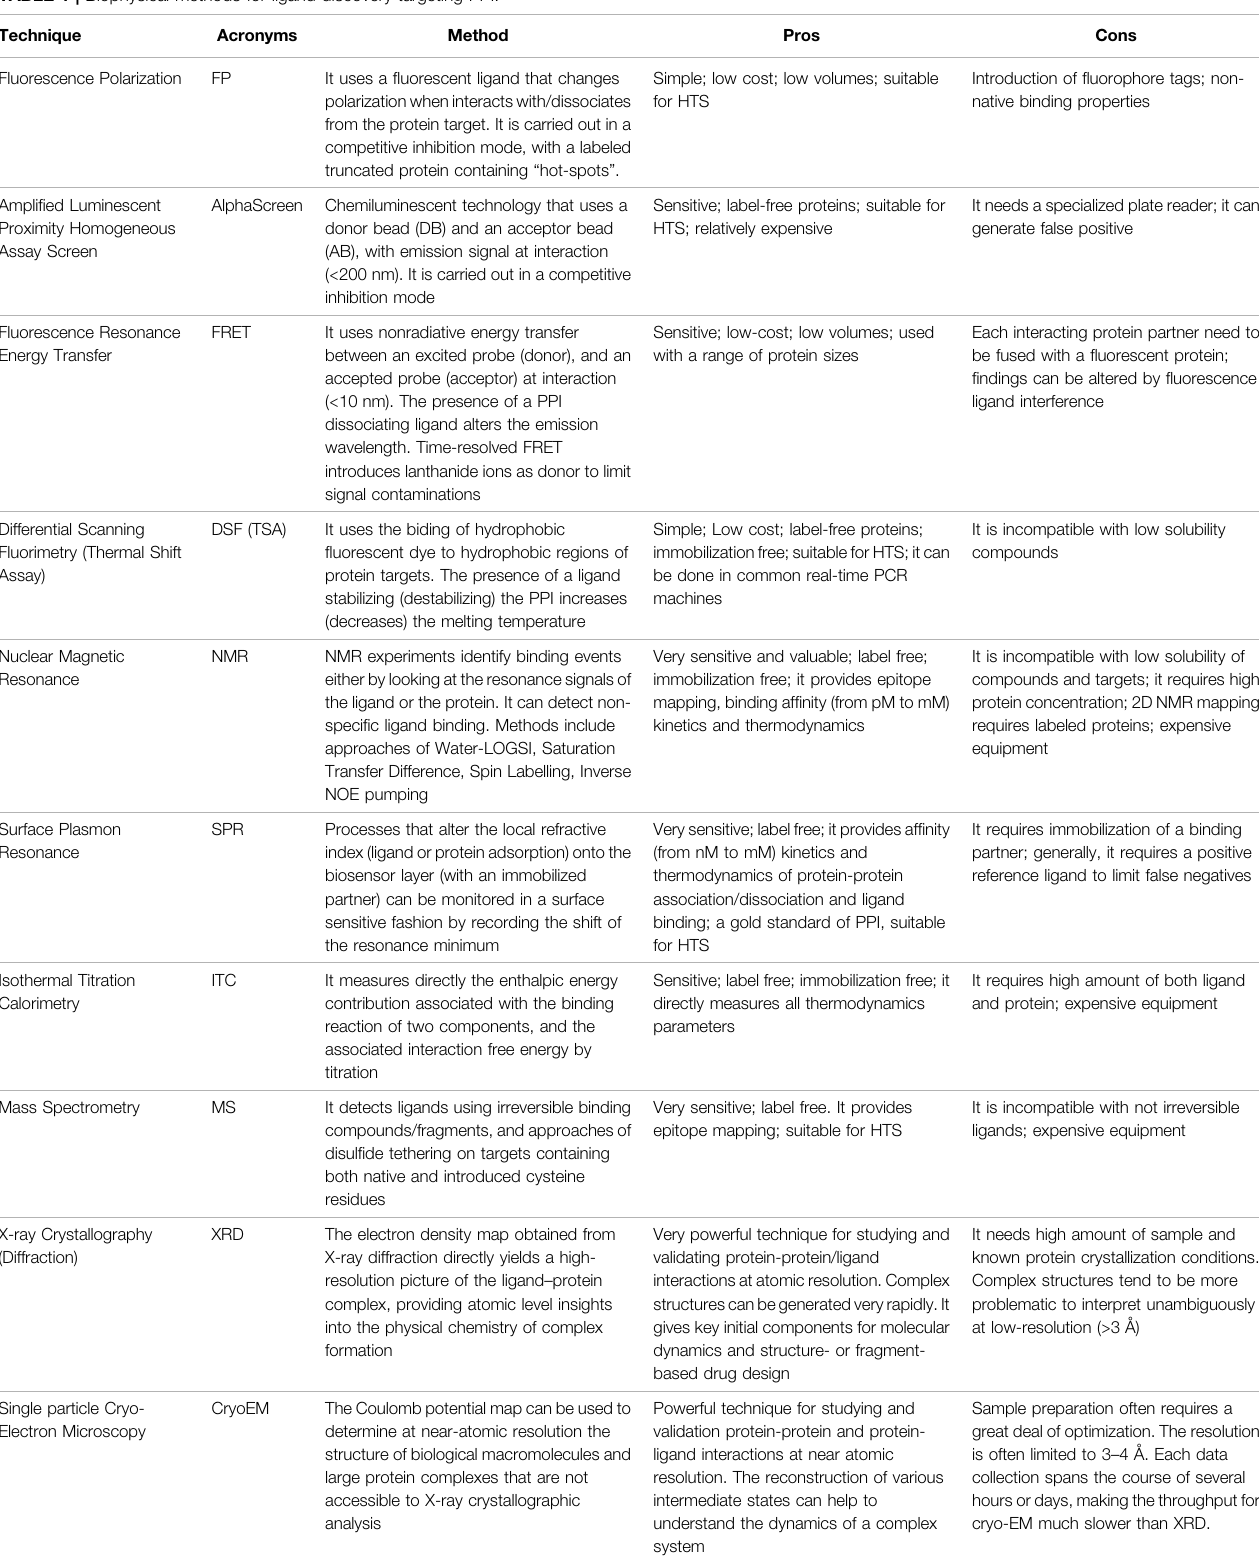
TABLE 1 | Biophysical methods for ligand discovery targeting